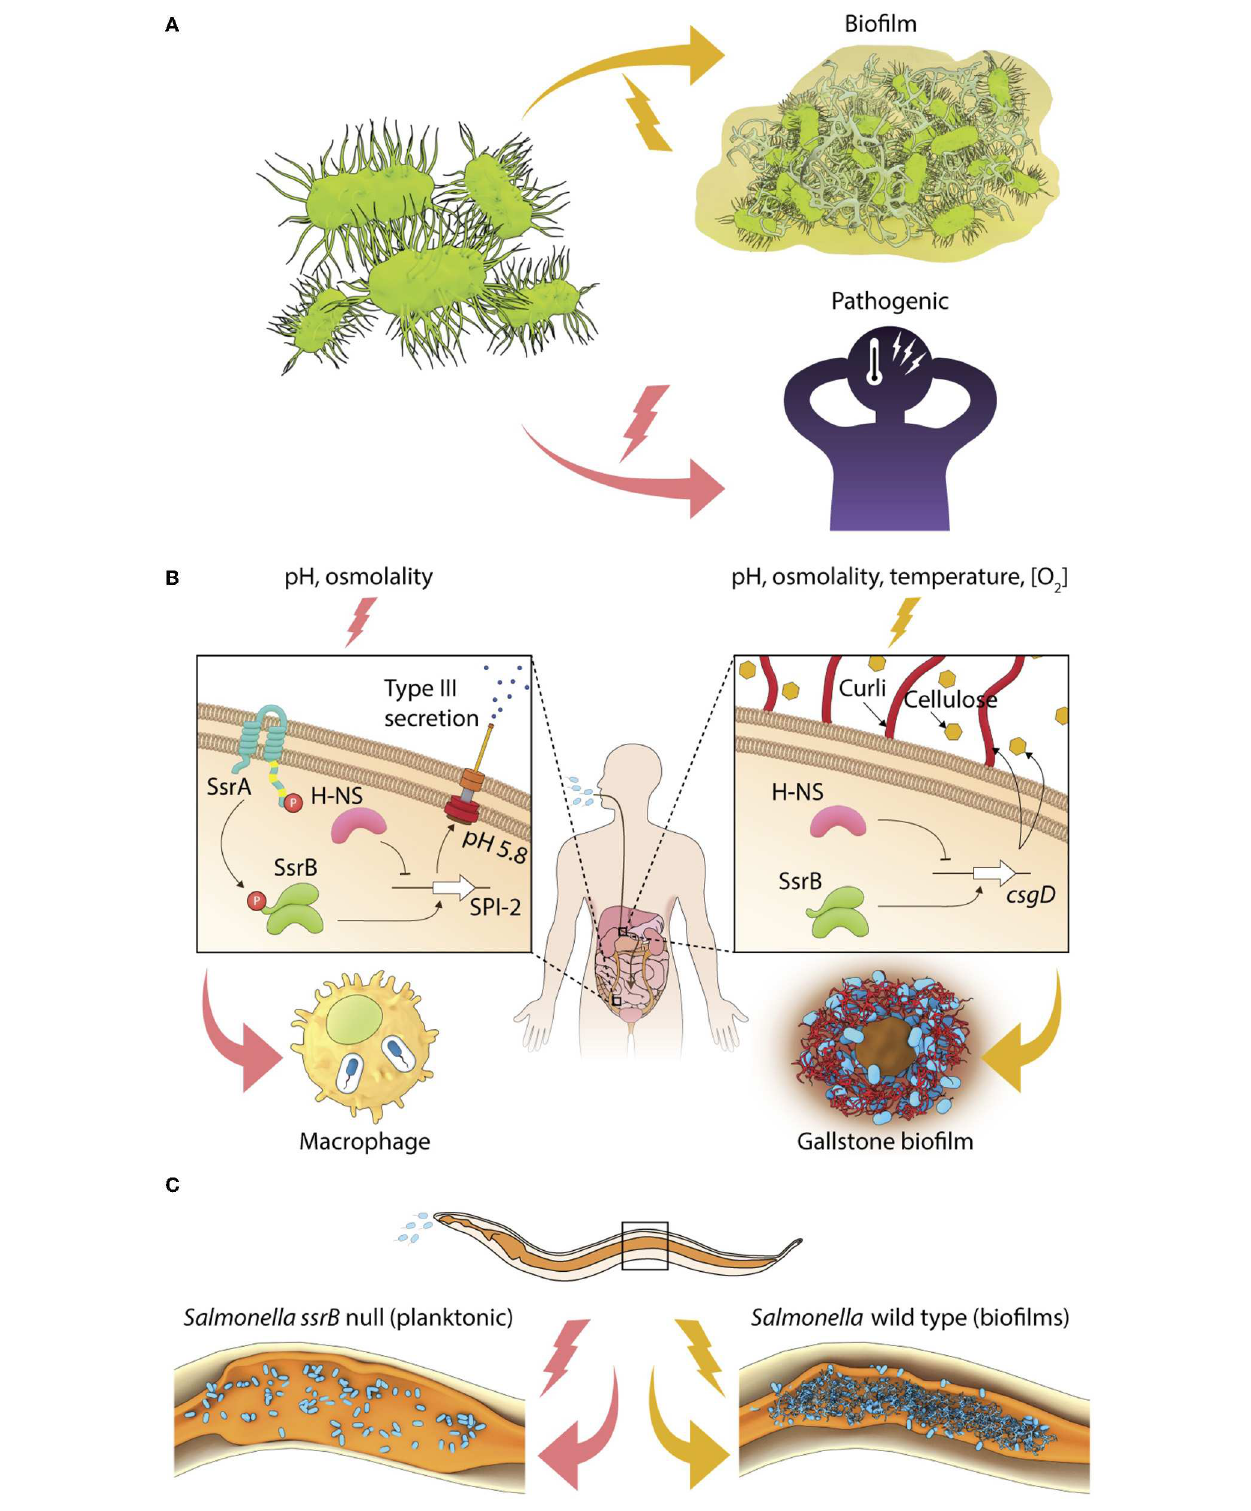
FIGURE 1 | Environmental regulation of bacterial lifestyles. (A) A general scheme depicting lifestyle switches in pathogenic bacteria to favor virulence or biofilm formation. (B) In Salmonella , SsrB ∼ P regulates the intracellular lifestyle and SsrB favors the formation of the carrier state and (C) Salmonella forms SsrB-dependent multicellular aggregates during persistent infections in C. elegans .